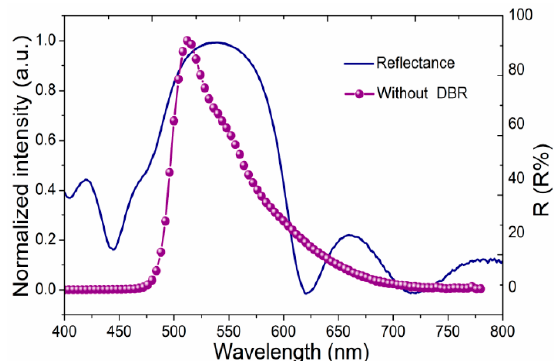
Figure 6. The reflectance spectrum of the distributed Bragg reflector (DBR) and the electroluminescence (EL) spectrum of a reference device without a DBR structure with the same configuration as Device A.